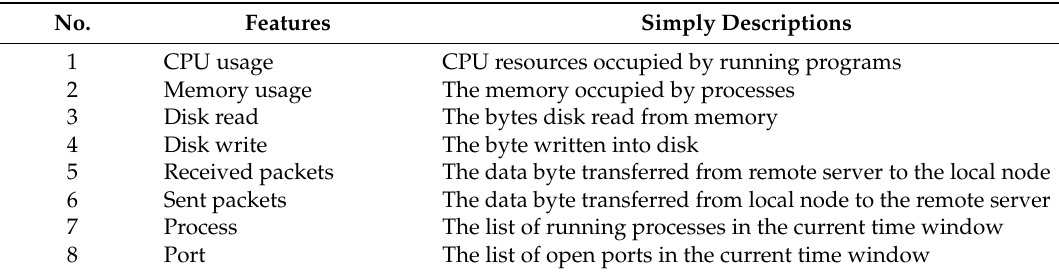
Table 1. Node-layer